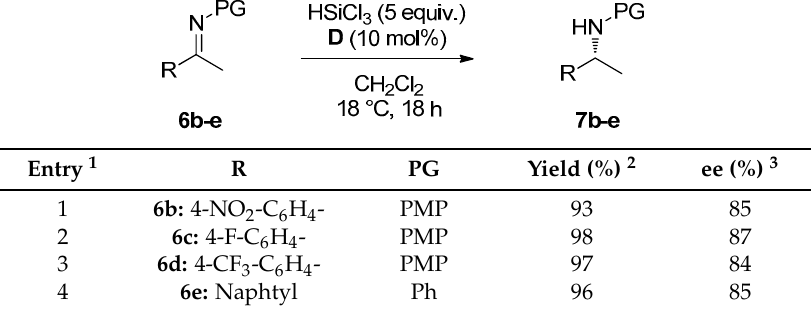
Table 2. Reduction of various imines with HSiCl 3 using polystyrene supported catalyst D .